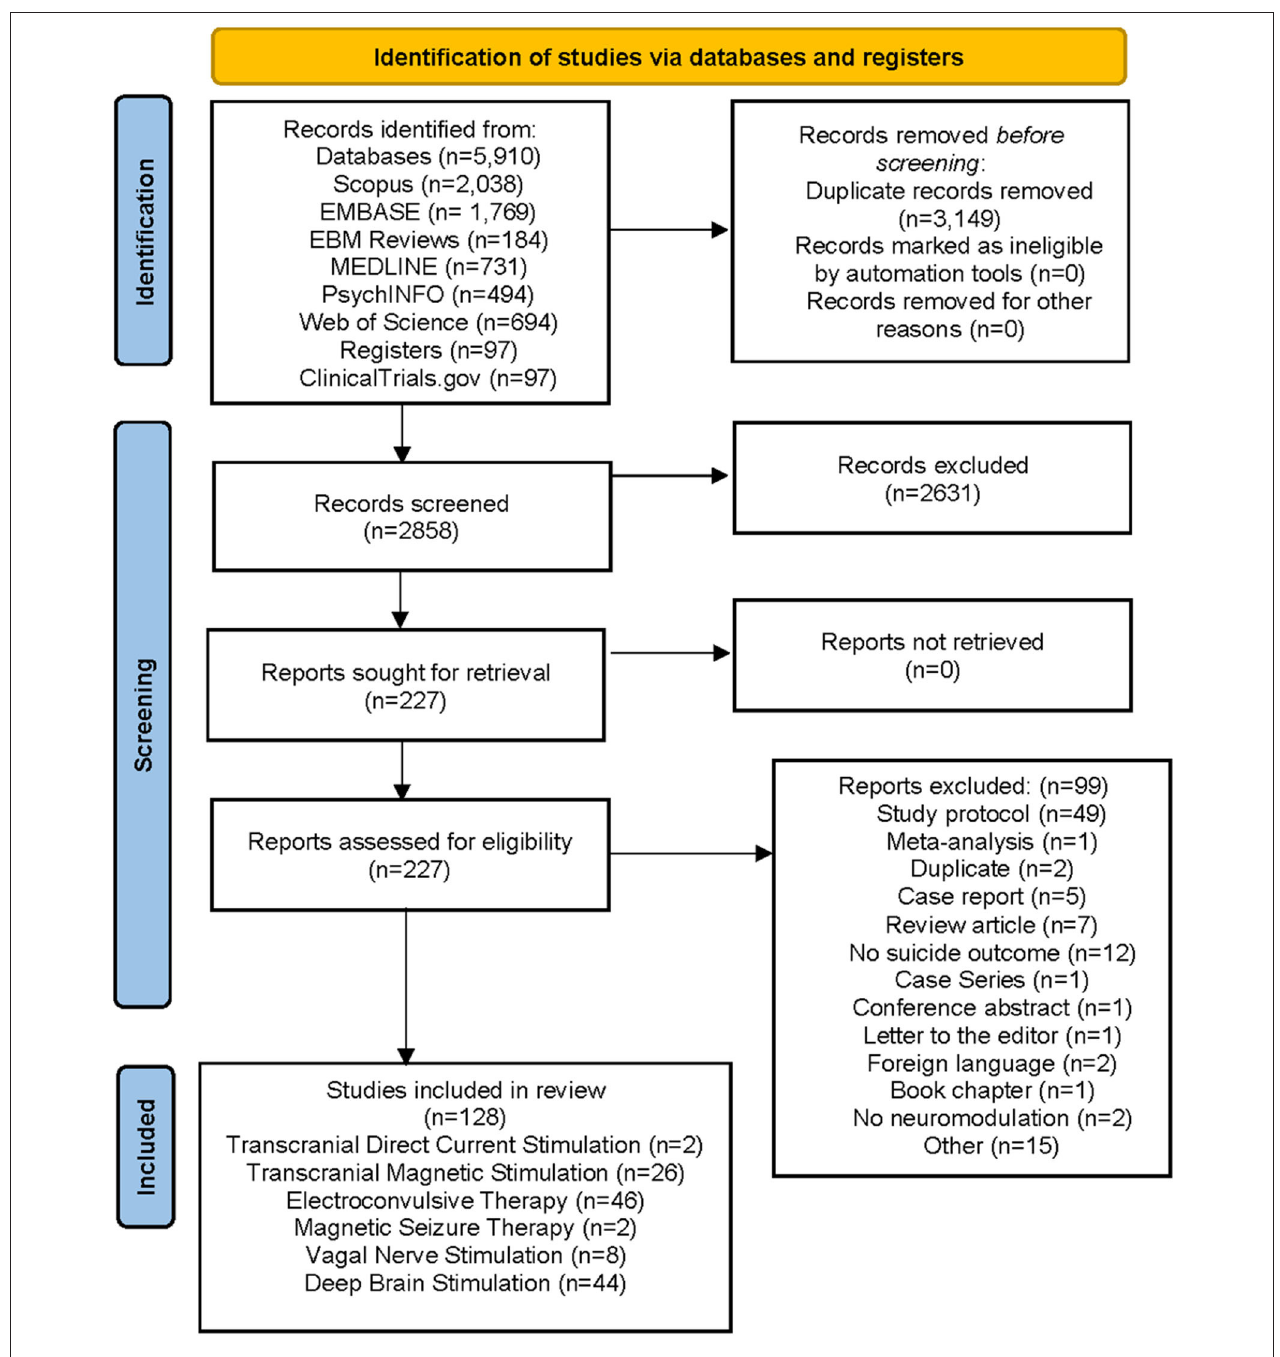
FIGURE 1 | PRISMA Flow